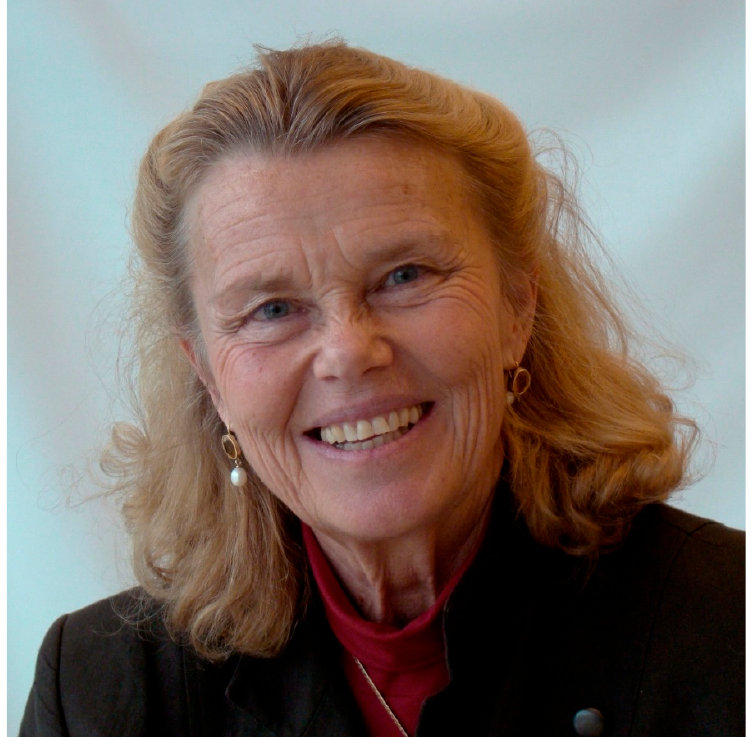
Figure 4. Prof. Dr. Adriana C. Gittenberger—de Groot. 1945–2020.